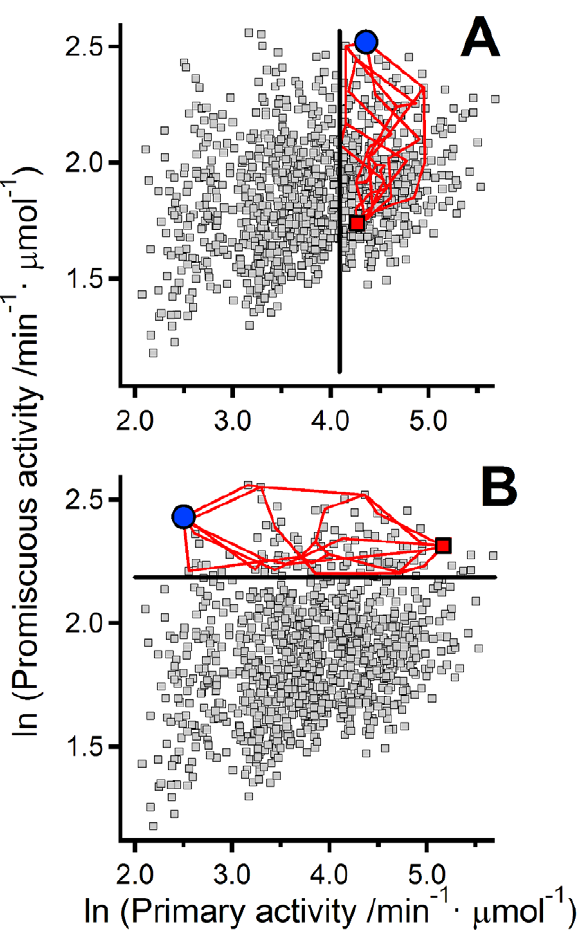
Figure 10. Diversity of mutational paths in the primary/ promiscuous activity space. Grey data points represent the results of a PLS reconstruction based on the 40-variant experimental set. Mutational paths (red lines) connecting a starting variant (red data point) and a final variant (blue data point) are shown. (A) The starting variant shows a low level of the promiscuous activity and a comparatively high level of the primary activity. Mutational steps are allowed if promiscuous activity is increased and the primary activity is maintained above a given threshold (shown as a vertical black line). (B) The starting variant shows high level of both, the primary and promiscuous activities. Mutational steps are allowed if the primary activity is decreased and the promiscuous activity is maintained above a given threshold (shown as a horizontal black line). immediately leads to a very large excess of a given protein, which may be deleterious. If imbalance is associated to an excessive level of the primary function, then the mutational paths in Figure 10B illustrate a potential of the mutational space explored by natural selection to efficiently restore balance.